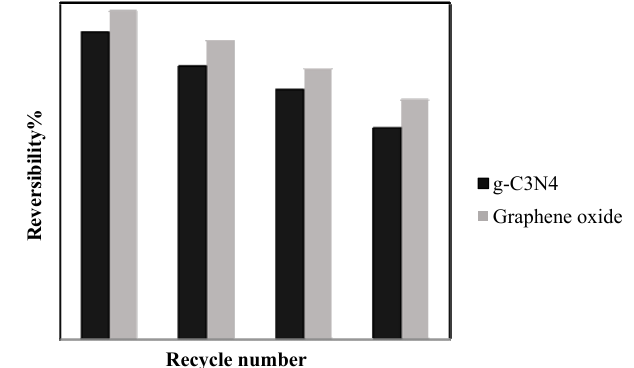
Fig. 9. Reversibility% for g-C